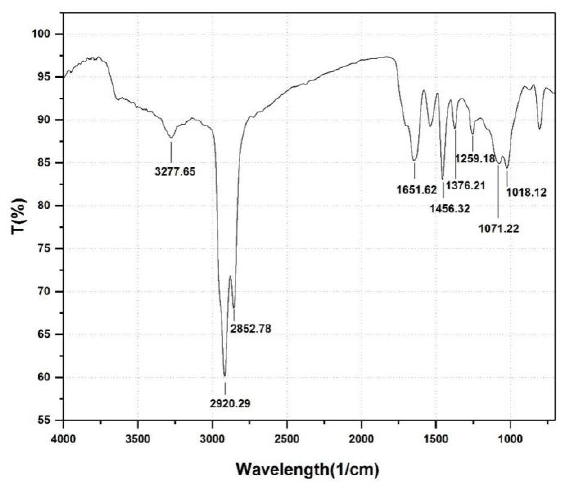
Figure 4. The infrared spectrum of the biosurfactant produced by Planococcus sp. XW-1.